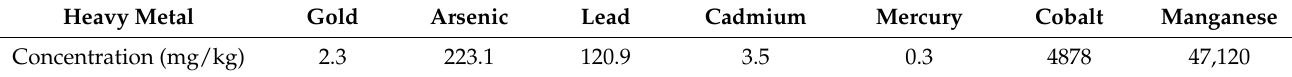
Table 2. Concentration of heavy metals in